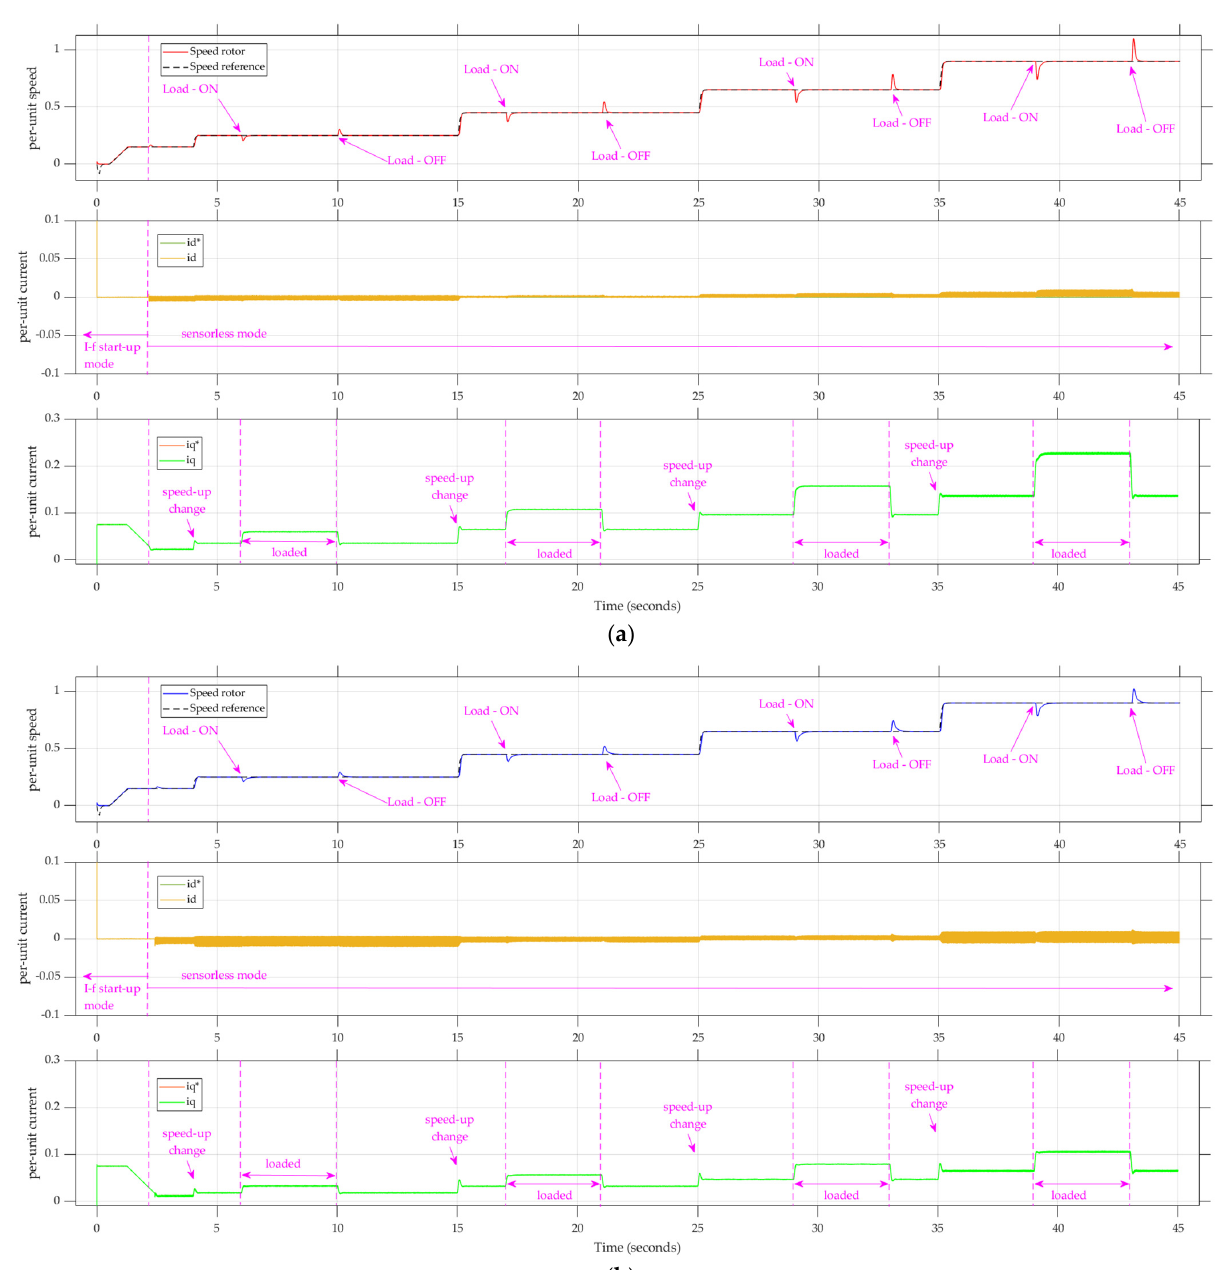
Figure 15. Speed and d-q current response of ( a ) PMSM 1 and ( b ) PMSM 4.